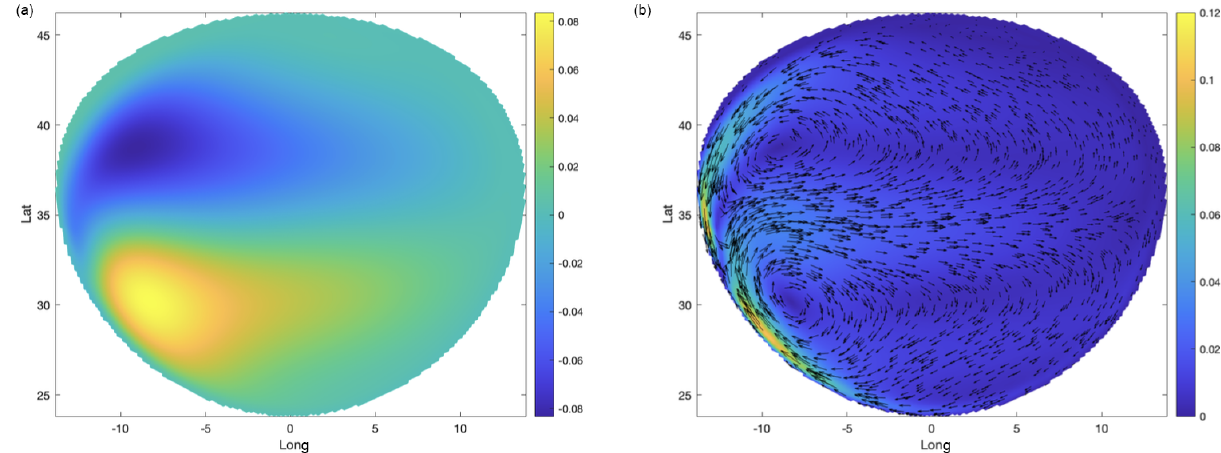
Figure 2. For the setting of Sect. 3.1, the RSWE truth model solution (8km resolution) with thickness h (a) and velocity field u (b) after integration of the system from rest for T =